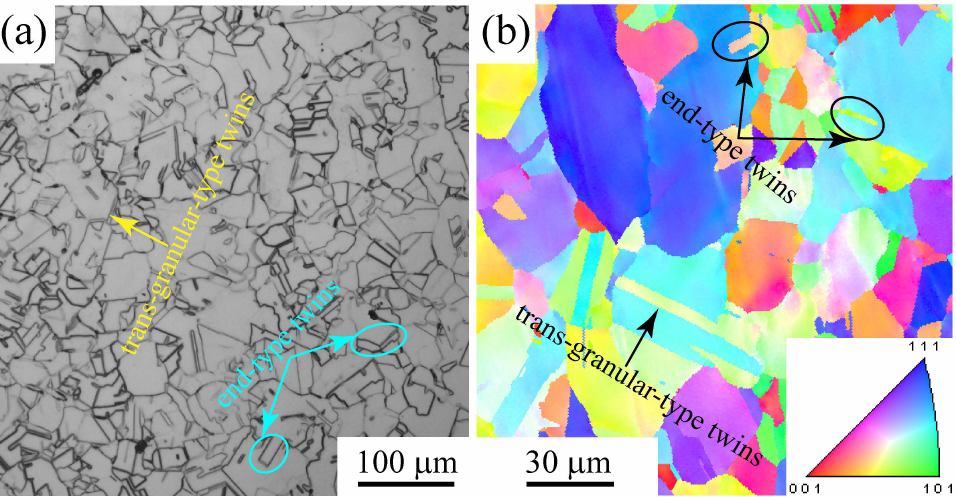
Figure 1. The microstructures of non-CR TWIP steel: ( a ) optical image and ( b )